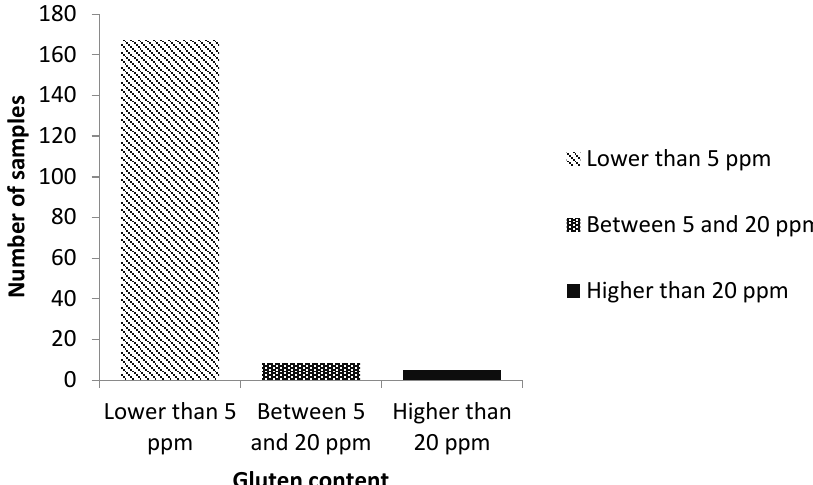
Figure 1. Distribution of gluten concentration of the collected samples.